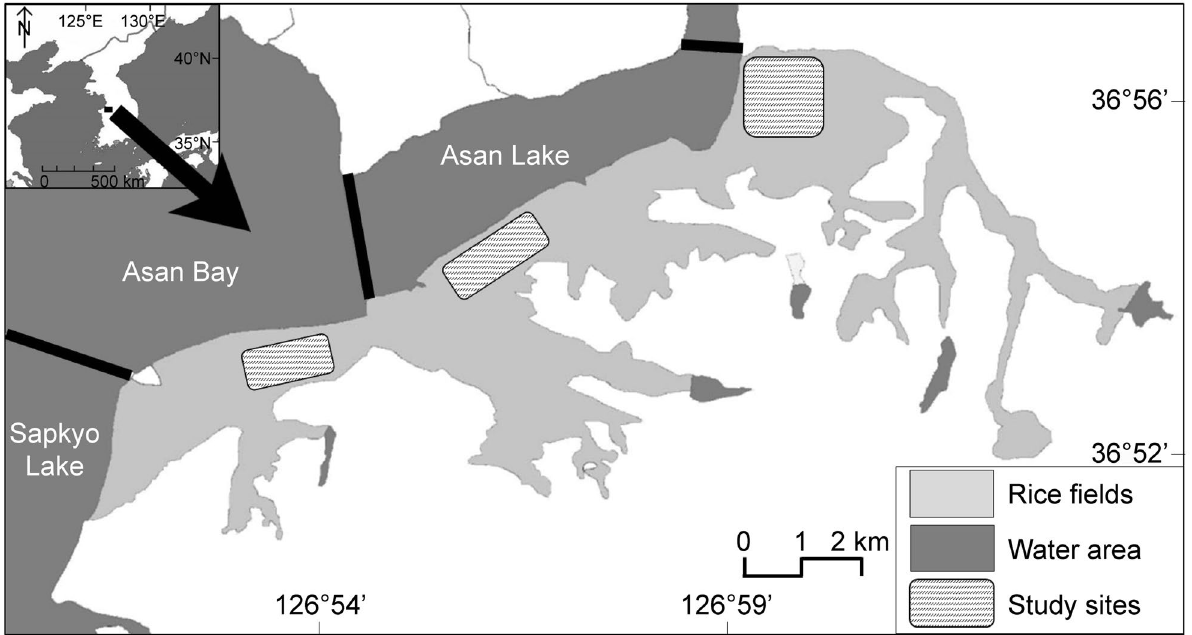
Figure 6. Map of the study area located in midwestern Korea, adjacent to Asan Lake and Asan Bay. The gray- shaded area is the overall rice-farming area, whereas the regions filled with dashed lines show the actual study sites. Created by Green Choi using Adobe Illustrator